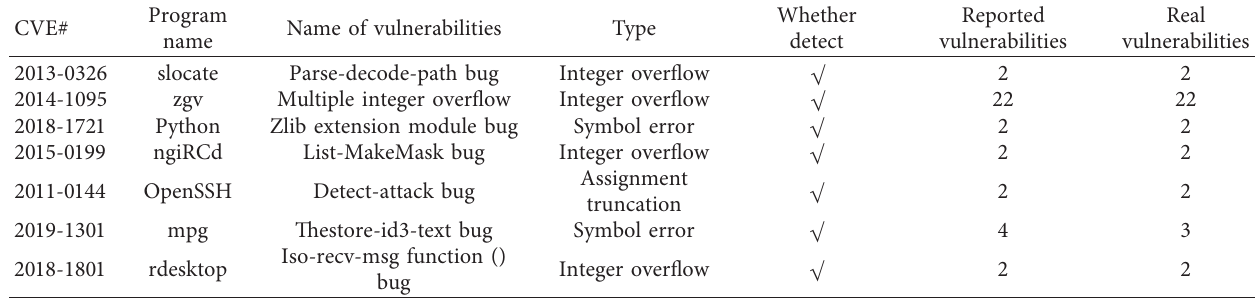
Table 3: Integer vulnerability detection.